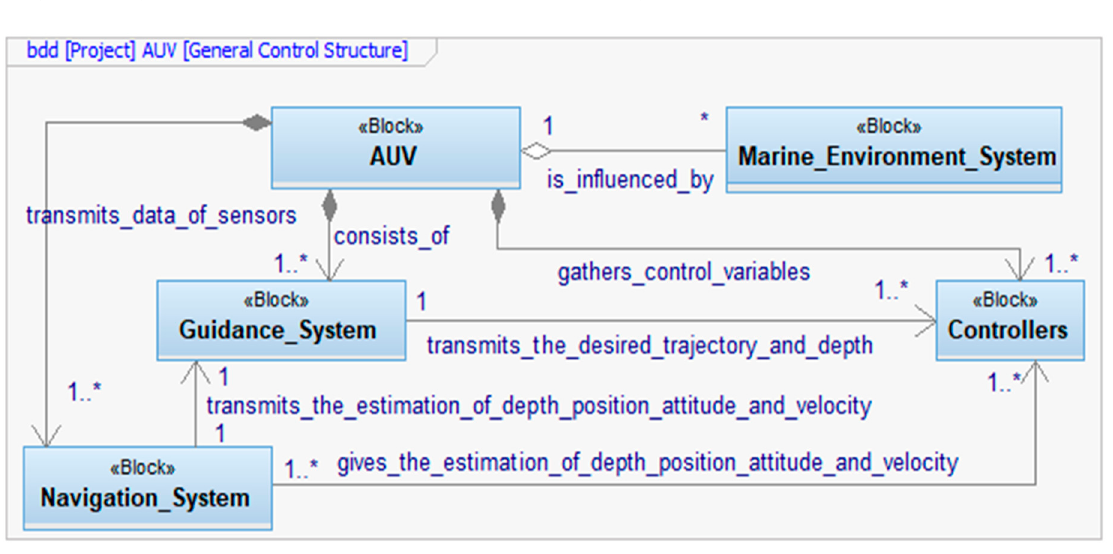
Figure 1. Autonomy architecture block definition diagram for an autonomous underwater vehicle (AUV).